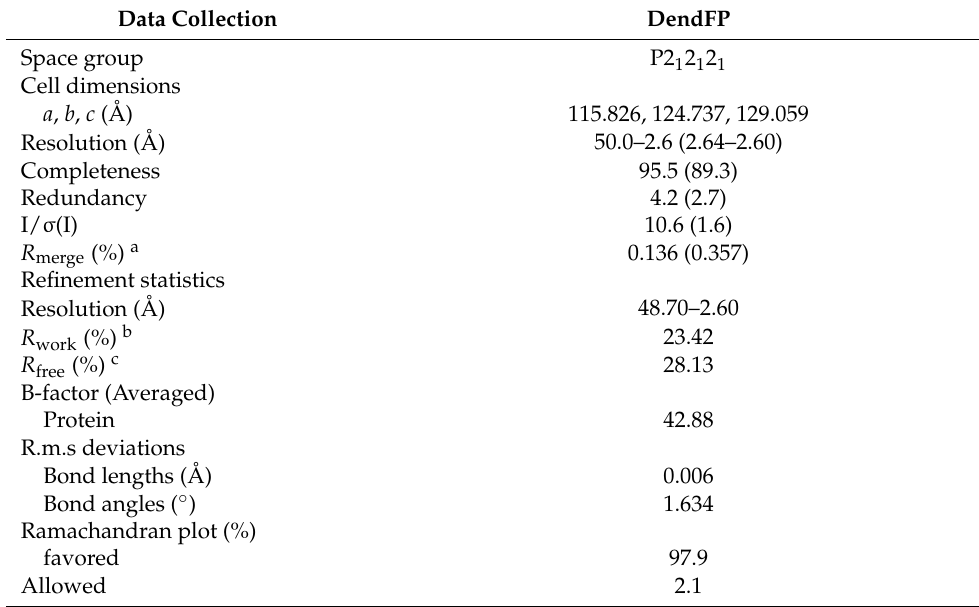
Table 1. Data collection and refinement statistics for DendFP.